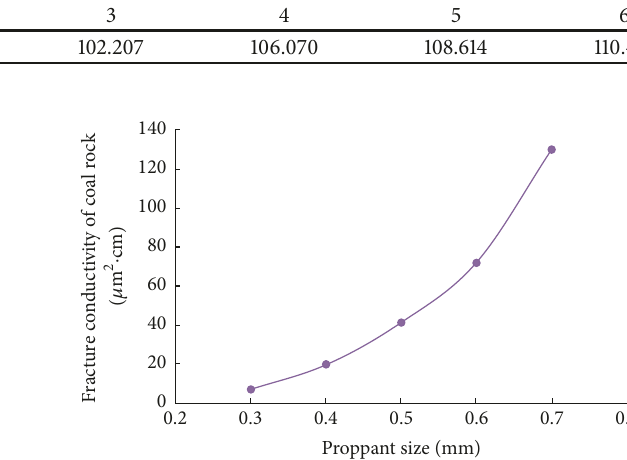
Figure 10: Relationship curve of fracture conductivity and Poisson’s ratio of proppant.